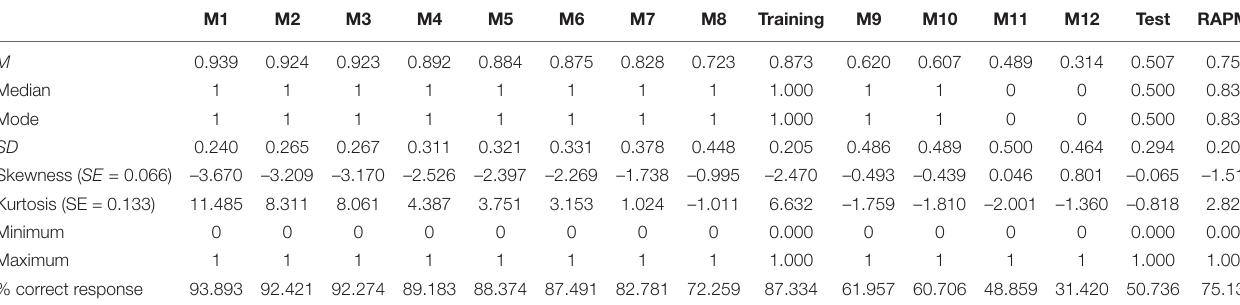
TABLE 1 | Descriptive statistics for Raven’s Advanced Progressive Matrices (RAPMs).